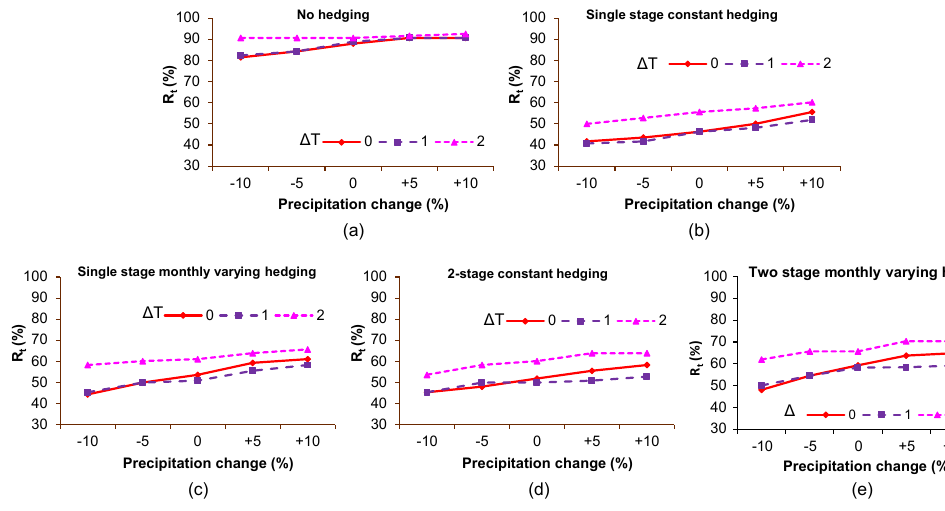
Figure 7. Hedging effect on reservoir performance (time-reliability).